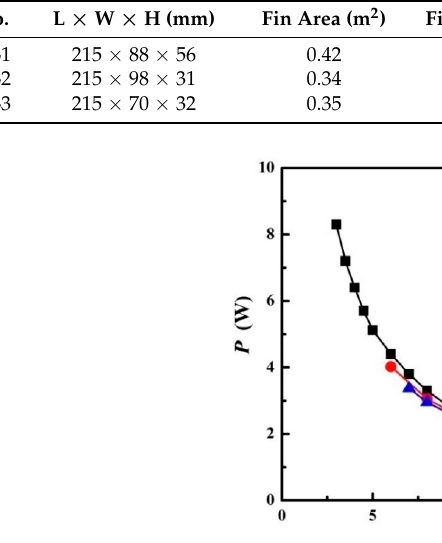
Table 5. Characteristics of different heat sinks for optimization.